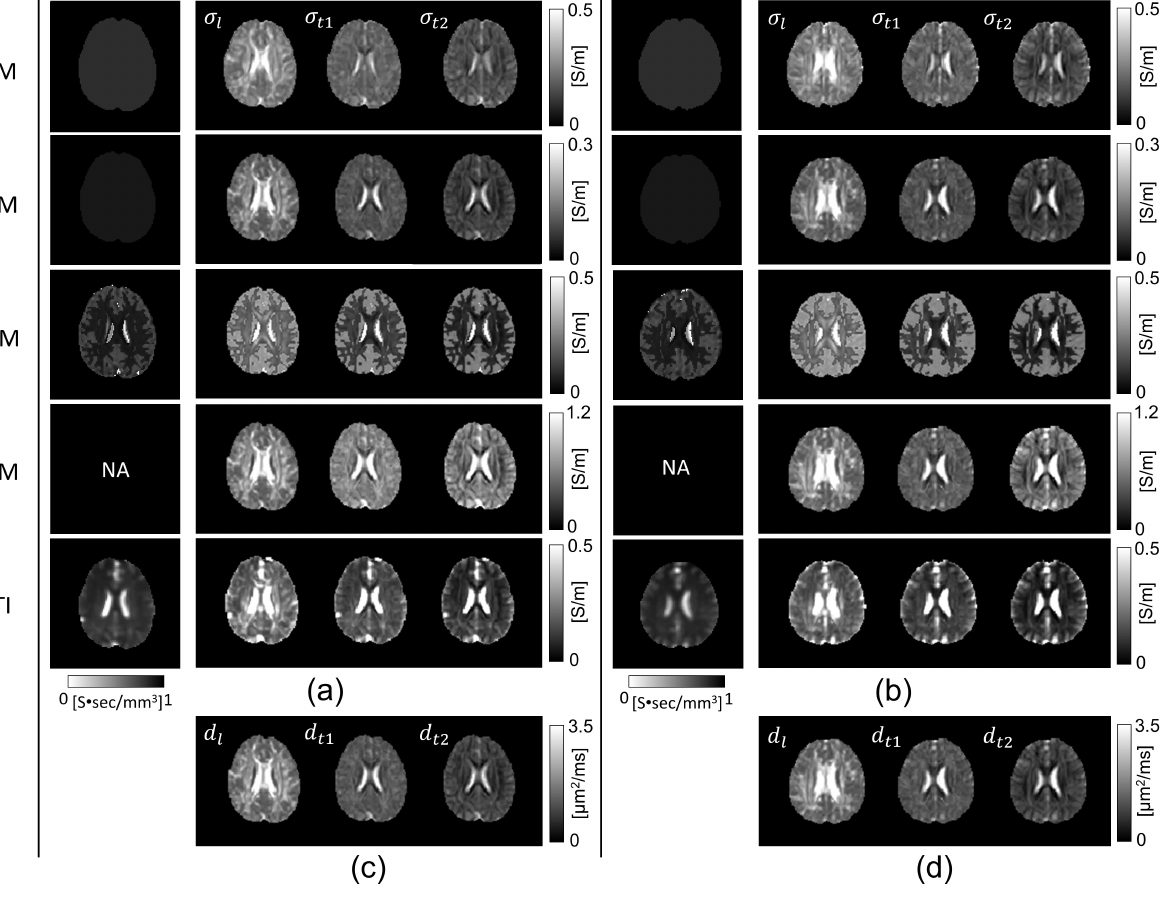
Figure 3. ( a , b ) are the longitudinal ( σ l ) and transversal ( σ t 1 and σ t 2 ) components of the reconstructed conductivity tensor images of the human brains from subjects #1 and #2, respectively, using the five methods of LEM, FEM, VCM, VFM, and CTI. ( c , d ) show the images of the water diffusion